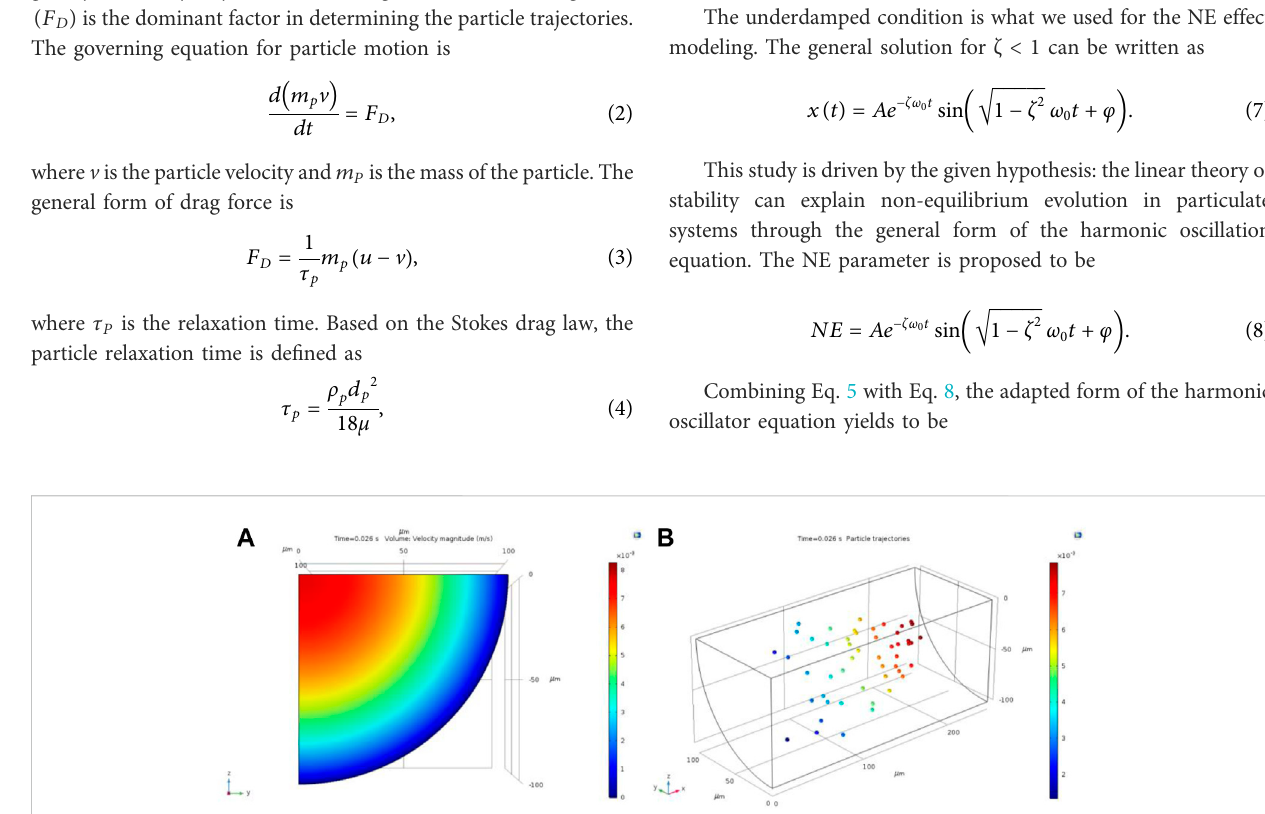
FIGURE 2 (A) Velocity pro fi les in the cross section and (B) particle trajectories in the straight-tube model. Color scale represents the magnitude of fl uid and particle velocities.